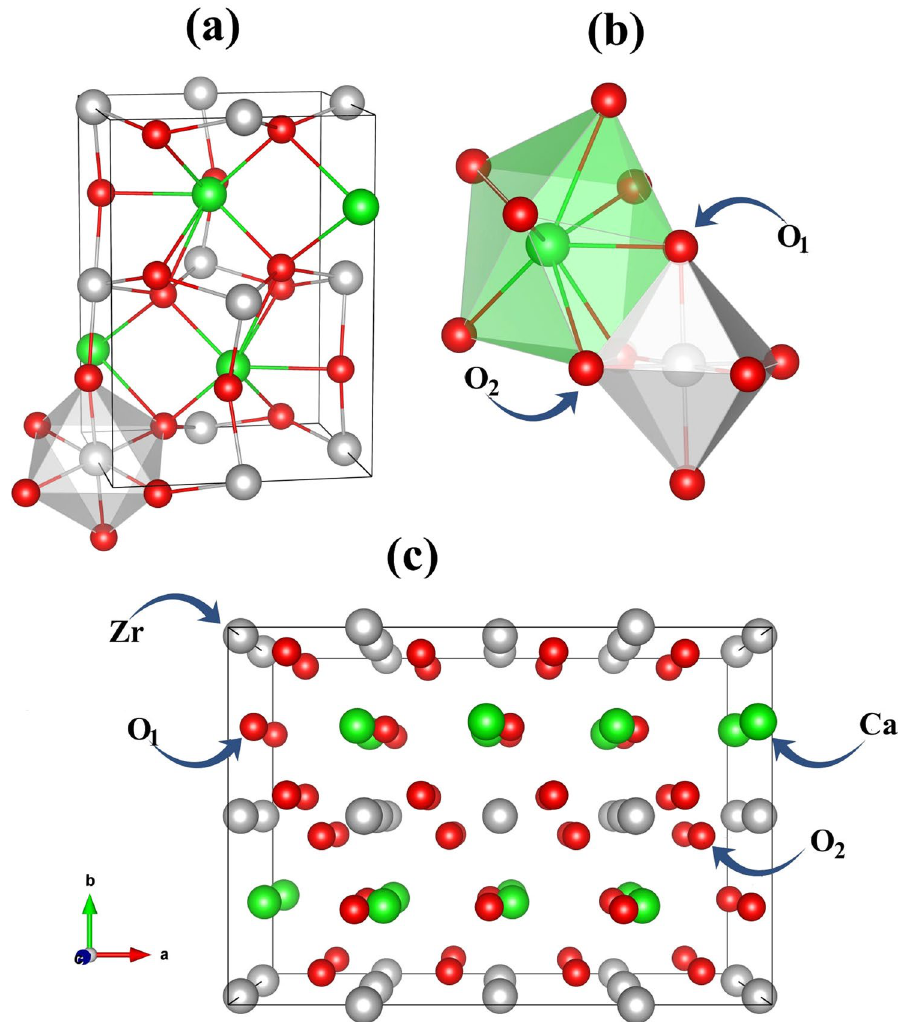
Figure 1. The ( a ) orthorhombic unit cell of CaZrO 3 along with ( b ) the anion coordination of Ca and Zr with apical (O 1 ) and equatorial (O 2 ) oxygen atoms. In ( c ) the pristine 2 × 1 × 2 supercell of CaZrO 3 is shown which was used for constructing supercells containing intrinsic vacancy defects and oxygen vacancy clustering as explained in the